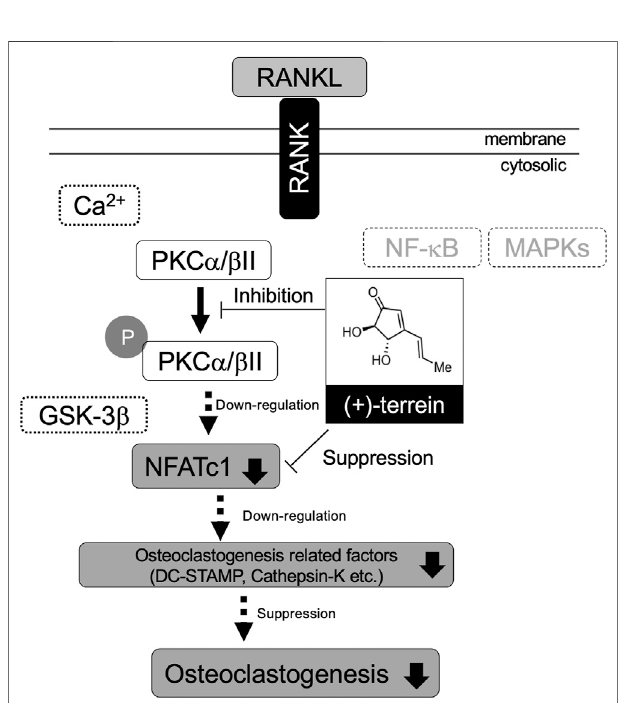
FIGURE 9 | Schematic representation of the effect of TER on RANKL- induced osteoclastogenesis via suppressing PKC α / β II phosphorylation.